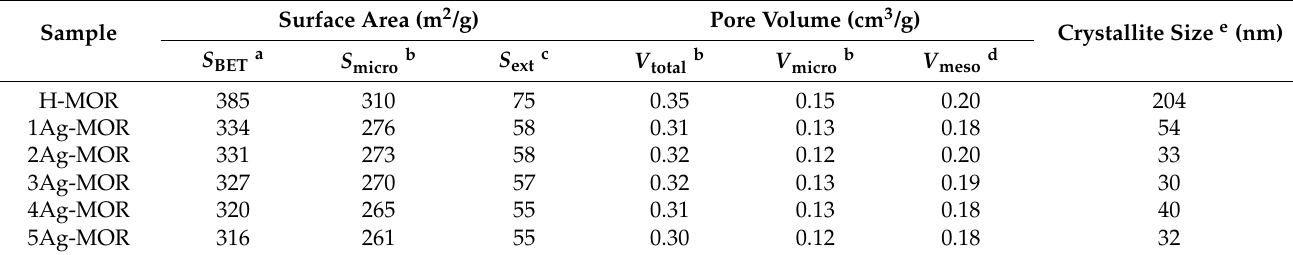
Table 1. Textural properties of the catalysts.